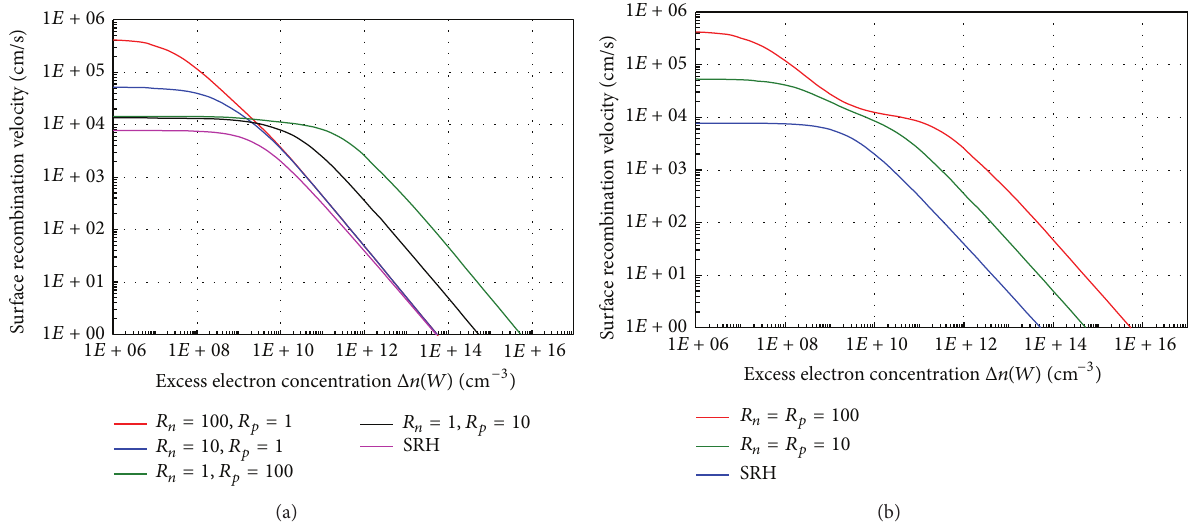
Figure 4: (a) Effective surface recombination velocity as a function of excess electron concentration for both SRH and amphoteric center recombination for 𝜓 𝑠 = 0.2 V, 𝐸